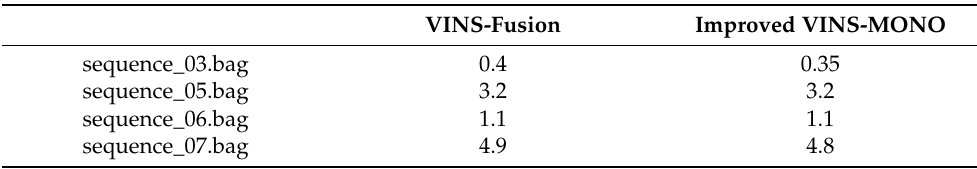
Table 10. The absolute pose error of VINS-Fusion algorithm is compared with that of the improved algorithm in the underwater dataset. (Unit: